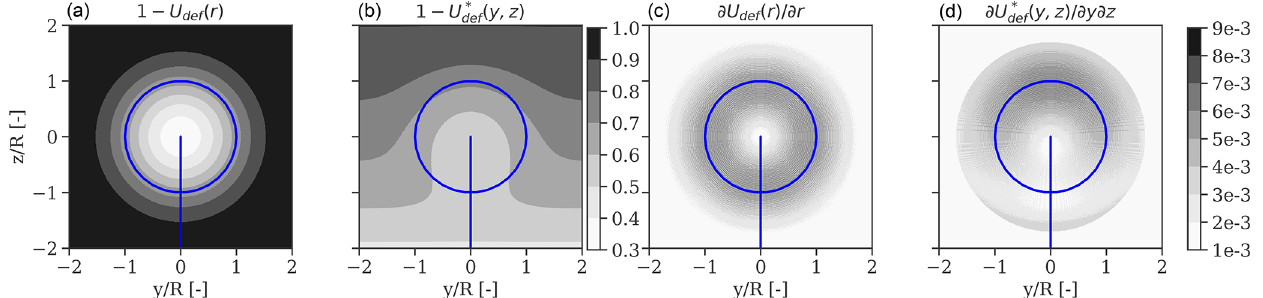
Figure 10. DWM-model-predicted flow characteristics. (a) Velocity deficit, (b) velocity deficit term with combined vertical shear profile U def ( y,z ) ∗ , (c) gradient of the velocity deficit, (d) gradient of the profile resulting from the combined velocity deficit and the vertical shear. The flow characteristics are computed for U amb = 6m/s, TI amb = 7%, and α = 0 . 25 at a downstream distance of 2.5 D